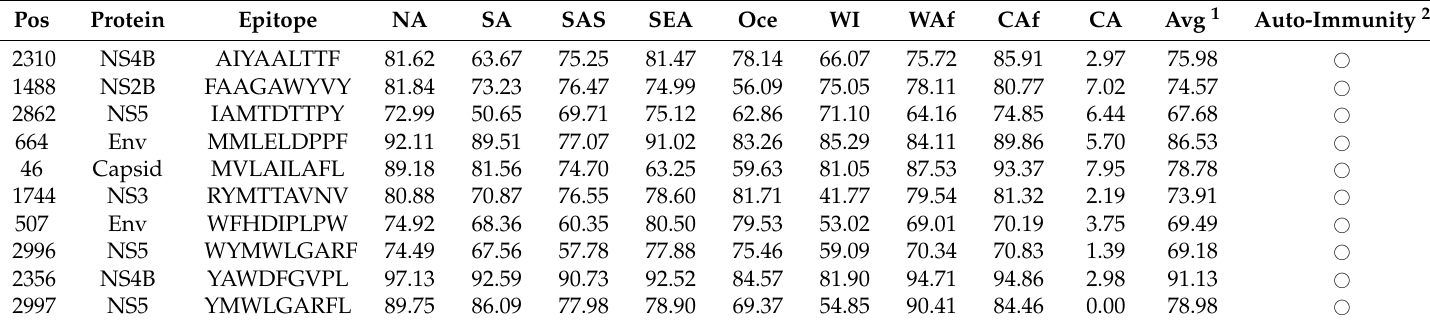
Table 2. HLA alleles for T-cell epitope mapping.